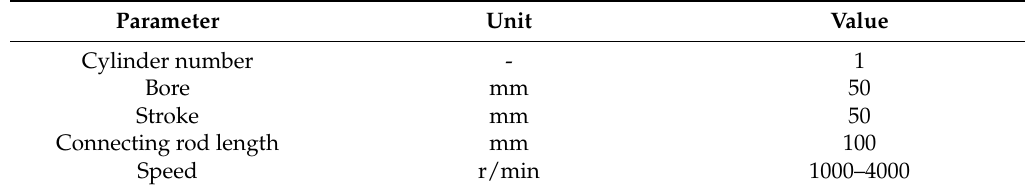
Table 3. Parameters of the